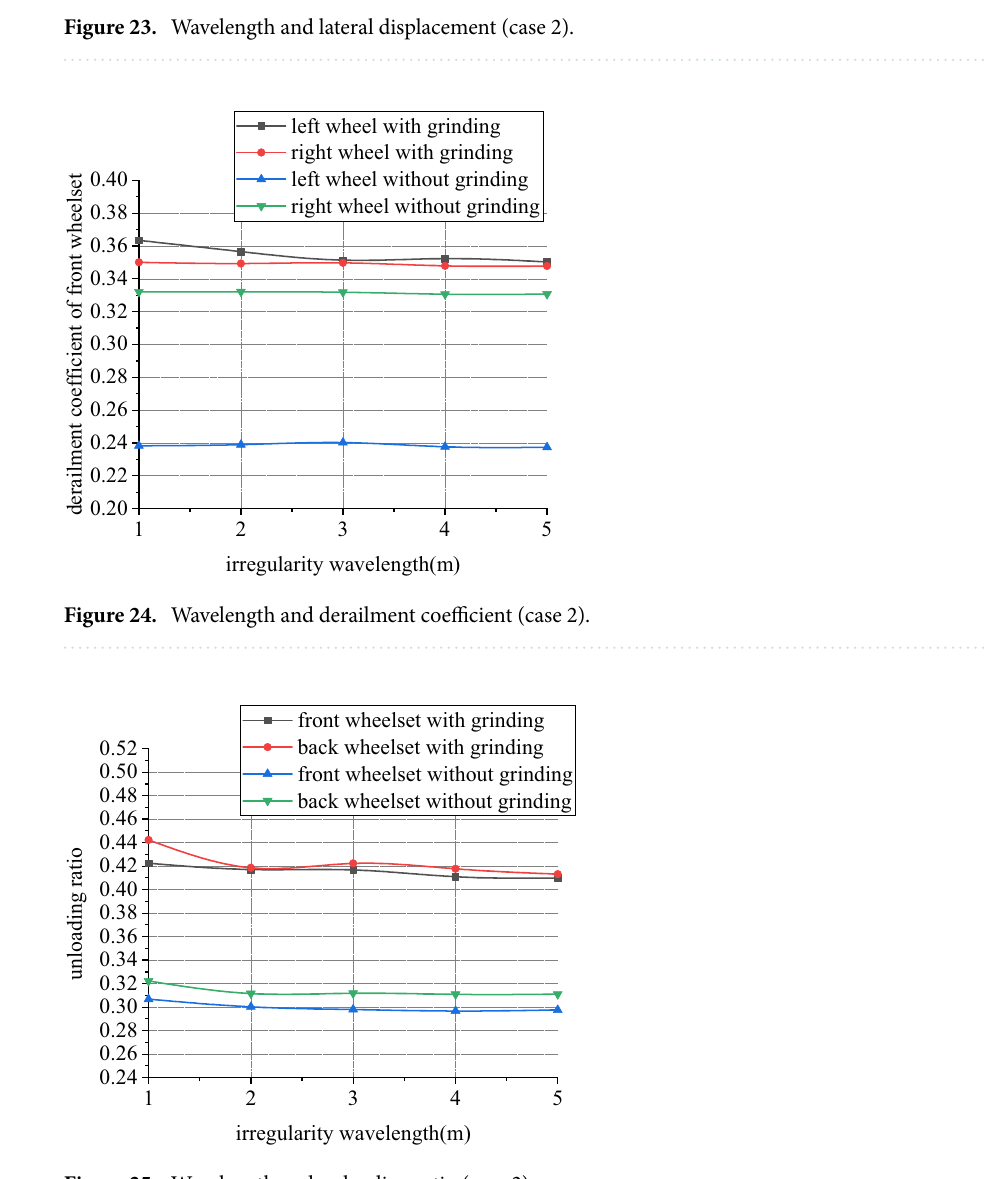
Figure 25. Wavelength and unloading ratio (case